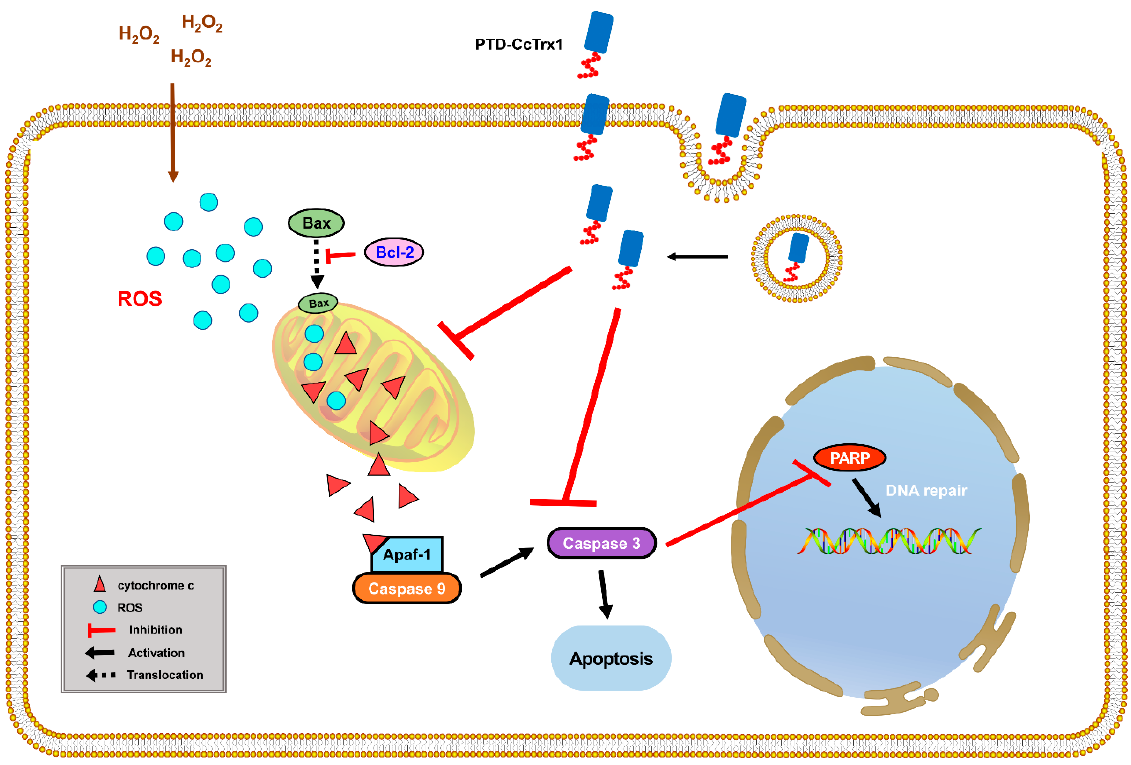
Figure 8. Possible mechanisms of the protective effect of PTD-CcTrx1 against H 2 O 2 -induced apop- tosis in HaCaT cells. H 2 O 2 induced the accumulation of intracellular ROS, which induced apoptosis by promoting the translocation of Bax and cytochrome c and then activating caspase 9 and caspase 3. PTD-CcTrx1 could penetrate the cell membrane and protect against H 2 O 2 -induced apoptosis by downregulating the Bax/Bcl-2 ratio, inhibiting the translocation of cytochrome c, and suppressing the activation of caspase 9 and caspase